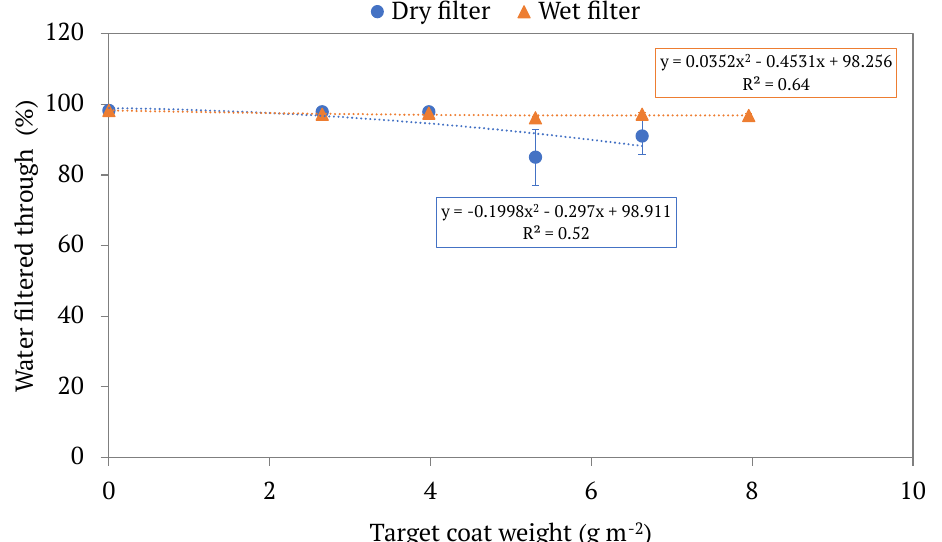
Figure 7. The water separation efficiency values, calculated by Equation (3), of different LCNF-modified filters by coat weight. Both dry and wet filters are displayed, each set with its own respective trendline. Each point represents the average water separation efficiency of multiple trials of modified filters with the same target coat weight, with the standard deviations of said values being displayed in the error bars.